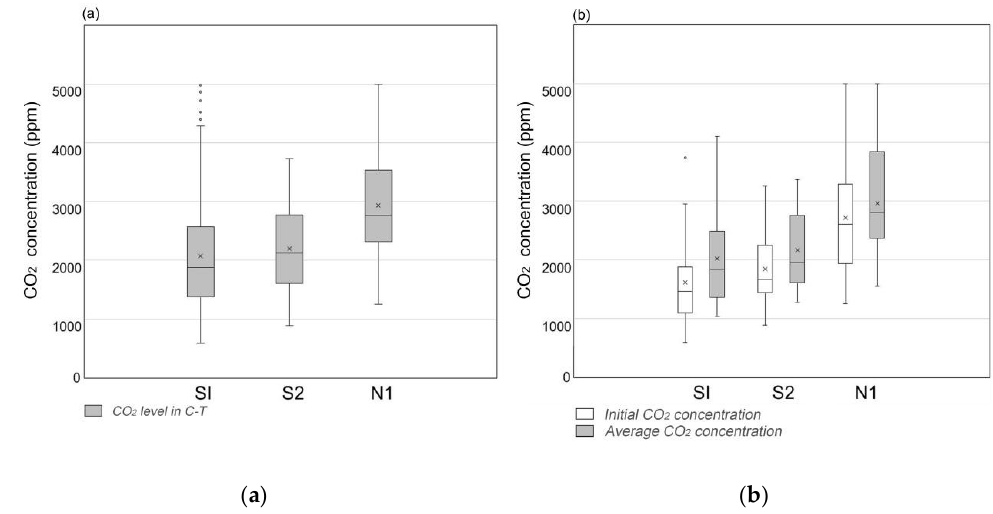
CO 2 concentration distributions: ( a ) initial CO 2 concentration and ( b ) average CO 2 concentration.